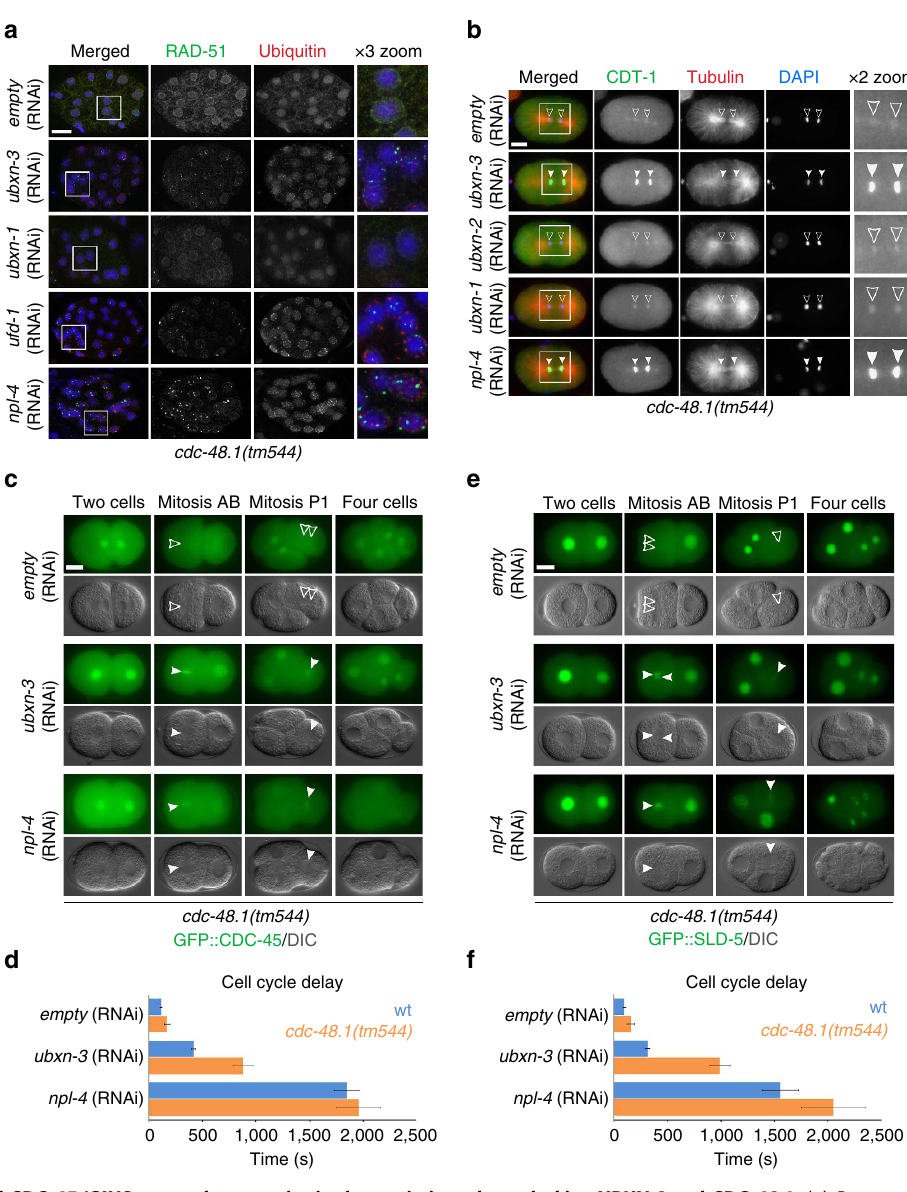
Figure 3 | CDT-1 and CDC-45/GINS accumulate on mitotic chromatin in embryos lacking UBXN-3 and CDC-48.1. ( a ) Representative projections of confocal z-stacks of embryos RNAi depleted for indicated genes in cdc-48.1(tm544) mutant. Embryos were immunostained for RAD-51 (green) and conjugated ubiquitin (FK2) (red). DNA was stained with DAPI (blue). The boxed area is three times magnified ( (cid:2) 3 zoom). Scale bar, 10 m m. ( b ) Immunostainings of one-cell stage cdc-48.1(tm544) mutant embryos RNAi depleted for indicated genes. CDT-1 (green), tubulin (red) and DAPI (blue) staining is shown as merge images and in separate channels. The boxed area is magnified by two times ( (cid:2) 2 zoom). Empty arrowheads indicate wt-like CDT-1 levels, filled arrowheads highlight increased CDT-1 levels on anaphase chromatin. Scale bar, 10 m m. ( c , e ) Selected images of time-lapse recordings of cdc-48.1(tm544) embryos expressing GFP::CDC-45 (green) or GFP::SLD-5 (green) that are depleted for empty control, ubxn-3 and npl-4 . Each image series shows representative cell-cycle phases of the mitotic division in the AB and P1 cell, respectively. Empty arrowheads point to wild-type-like CDC-45 and SLD-5 localization, filled arrowheads indicate persistent association of the indicated proteins with mitotic chromatin. DIC is shown in grey. Scale bar, 10 m m. ( d , f ) Quantification of the cell delay between AB and P1 cell division (cell-cycle delay) of wt (blue) and cdc-48.1(tm544) (orange) embryos depleted for empty , ubxn-3 and npl-4 by RNAi. Time is shown in seconds. Evaluation of cell division timing was done in embryos expressing GFP::CDC-45 ( c ) and GFP::SLD-5 ( e ), respectively. Error bars show s.e.m. Mean values are based on two to six individual recordings per